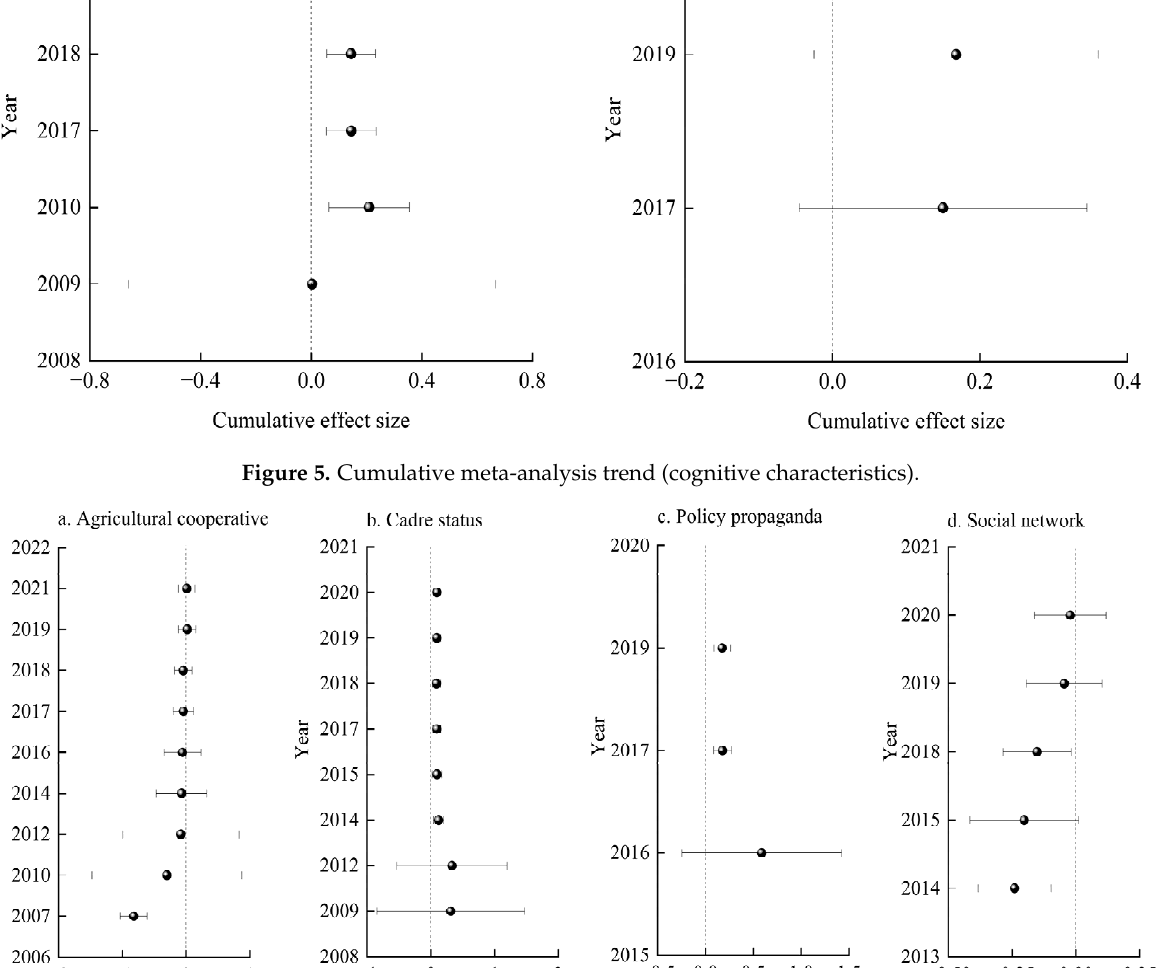
Figure 6. Cumulative meta-analysis trend (external conditions). The missing year indicates that there is no corresponding effect size for that year, the solid circle of the line segment in the figure represents the cumulative effect size, and the left and right sides are 95% confidence intervals.